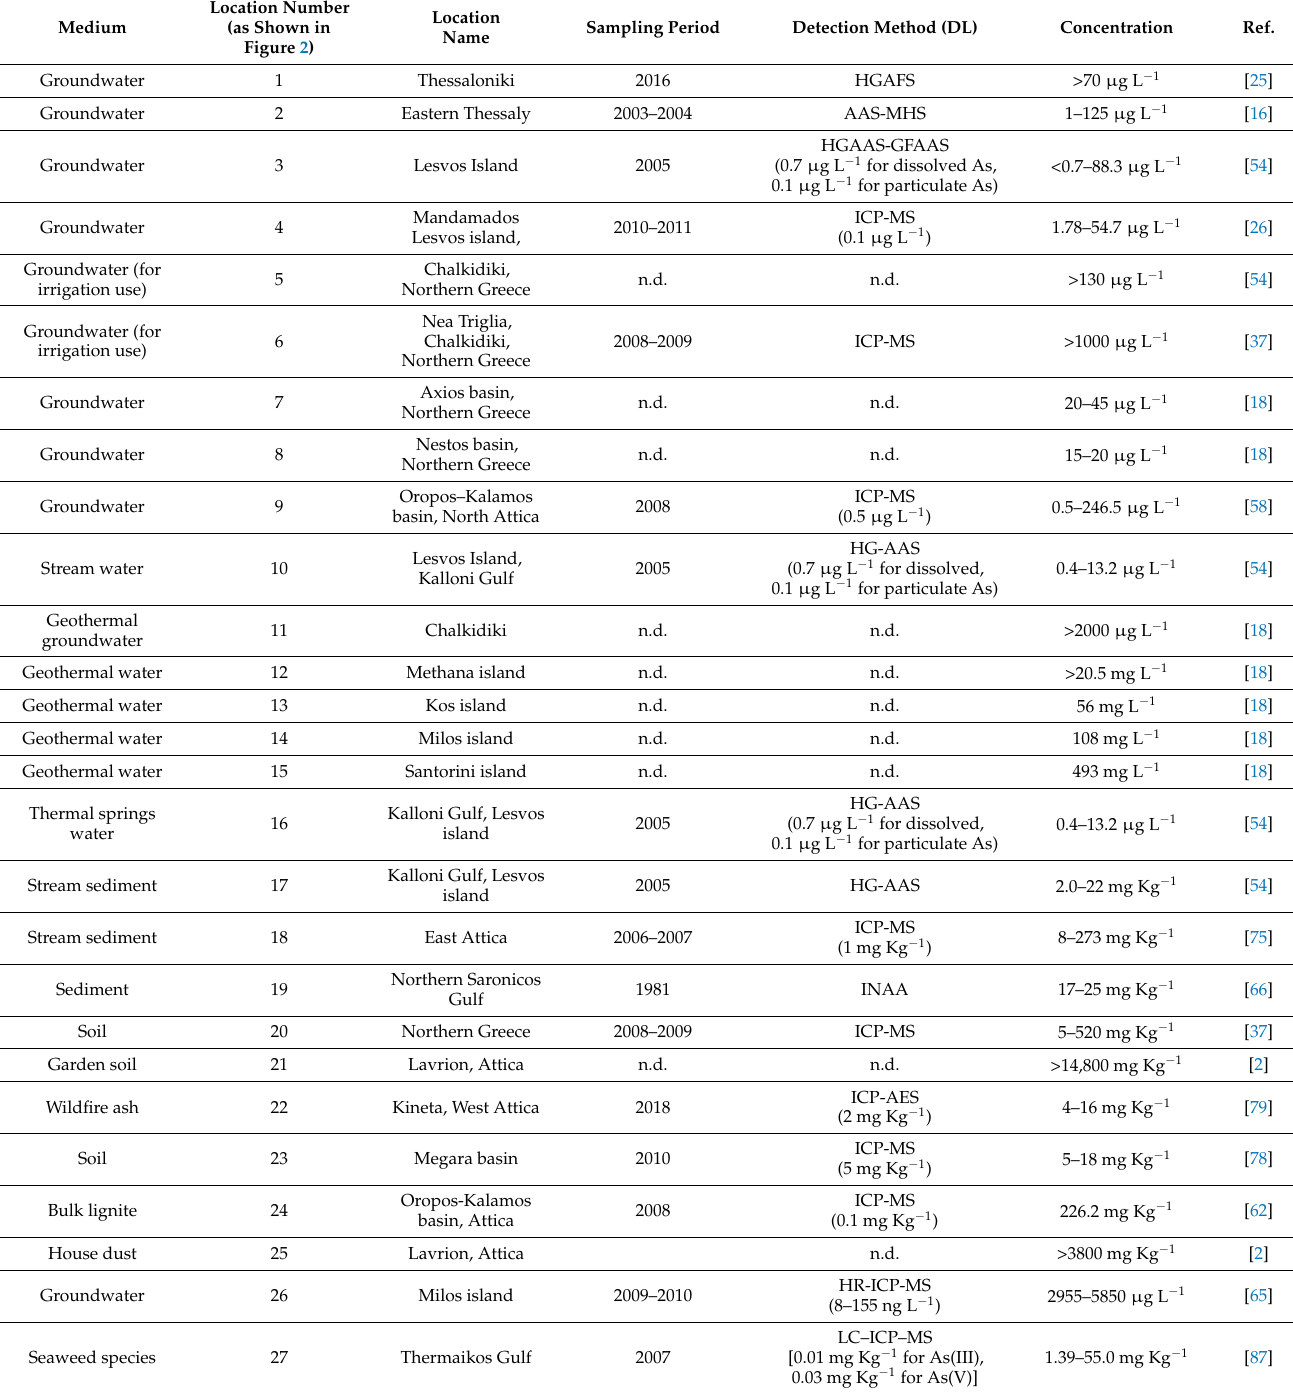
Table 2. Concentration of As in various media in Greece and Cyprus. (HGAFS: Hydride generation atomic fluorescence spectrometer, AAS-MHS: Atomic absorption spectroscopy with a mercury hydride system, HGAAS: Hydride generation atomic absorption spectrometry, GFAAS: Graphite furnace atomic absorption spectroscopy, ICP-MS: Inductively coupled plasma-mass spectrometry, ICP-OES: Inductively coupled plasma optical emission spectroscopy, INAA: Instrumental neutron activation analysis, ICP-AES: Inductively coupled plasma atomic emission spectrometry, HR-ICP-MS: High resolution inductive coupled plasma-mass spectrometer, ICP-TOFMS: Inductively coupled plasma time-of-flight (TOF) mass spectrometer, DL: Detection limit, n.d.: no data). Location Number Location Medium (as Shown in Name Sampling Period Detection Method (DL) Concentration Figure 2)